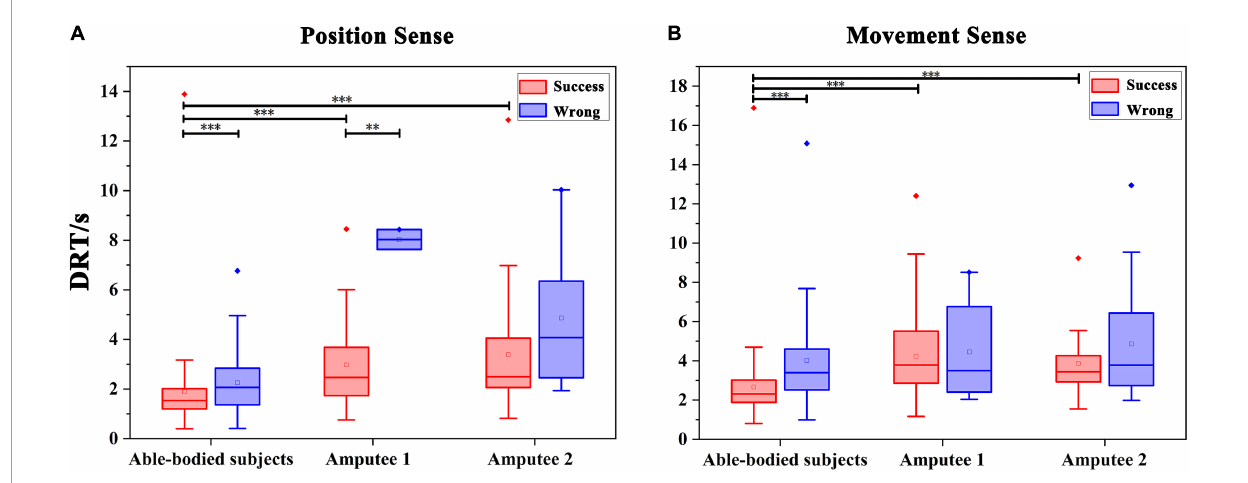
FIGURE7 Statistics of the DRT (discrimination reaction time) in Exp 1 and Exp 2. (A) DRT for the evaluation of wrist FE position sense by all subjects. ∗∗ p < 0.01, ∗∗∗ p < 0.001. (B) DRT for all subjects spent in evaluating the wrist FE movement sense. ∗∗∗ p < 0.001.